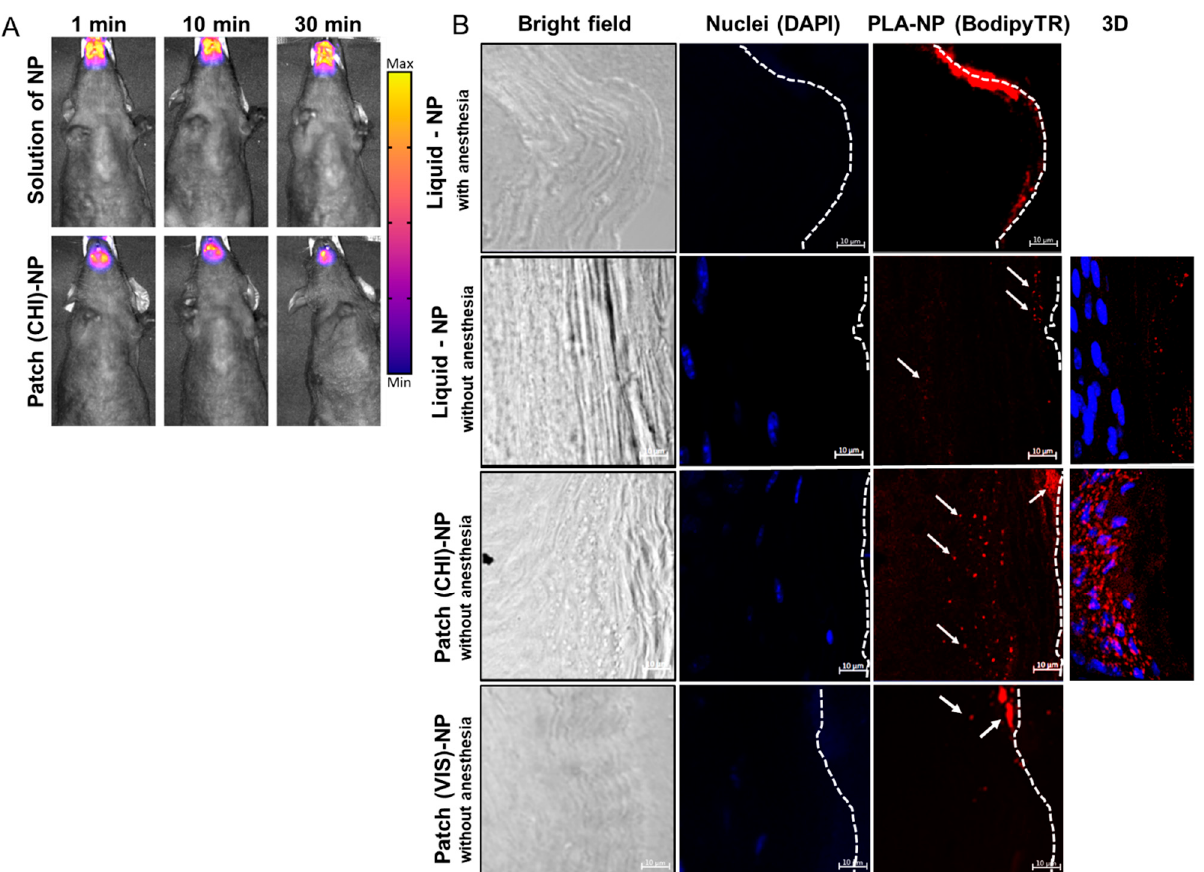
Figure 3. PLA-NP residence and transport through the SL mucosa. ( A ) Fluorescence molecular tomography of PLA-NP ICG (indocyanine green) in solution or incorporated in the LbL patch. Fluorescent signal was detected 1, 10, or 30 min after administration. ( B ) PLA-NP visualized by confocal microscopy 10 min after administration as a liquid dosage or by a mucoadhesive LbL patch made of CHI or VIS combined with HyA. The pictures were taken with a 40× objective lens with a zoom factor of 4×. White arrows indicate fluorescent PLA-NPs, and dashed lines represent the outer surface of the SL mucosa. The panels on the right side of the figure are 3D reconstructions (maximum-intensity projection) of optical sections from 40 µm thick cuts of SL mucosa (ventral part of the tongue).